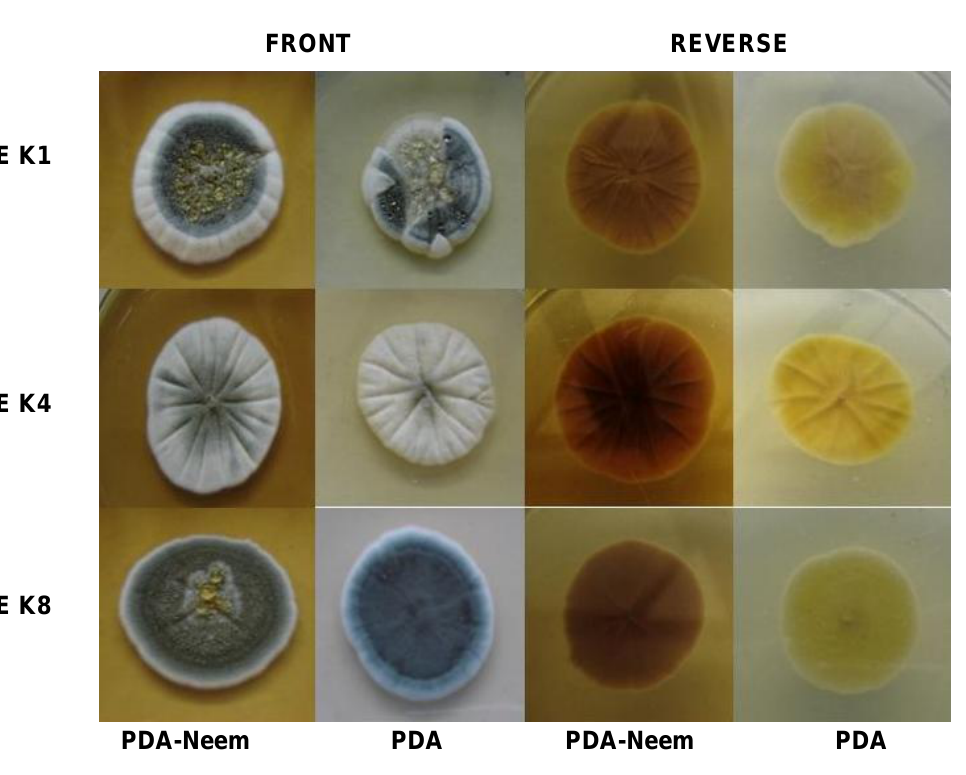
Figure 3 . Citrinin production from P. citrinum isolates determined by